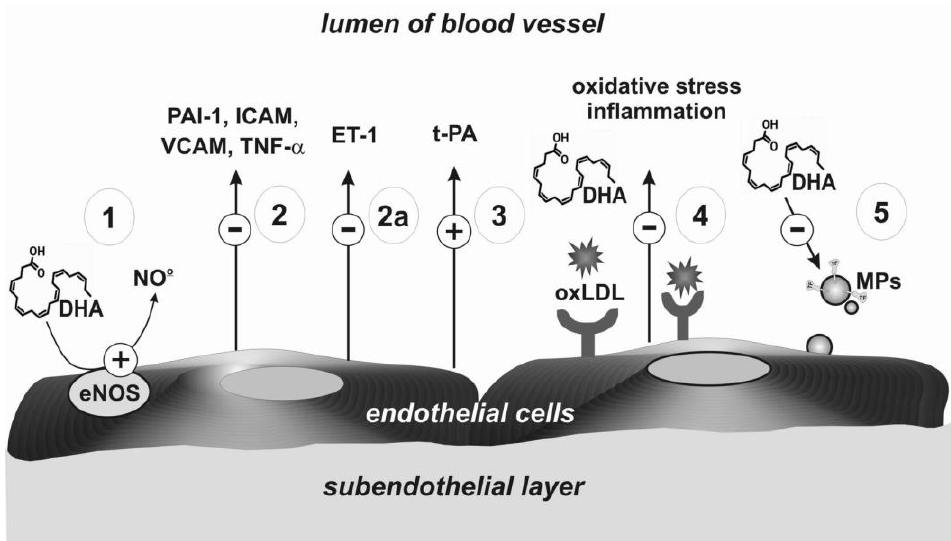
Figure 3. Mechanisms of endothelium regulation mediated by EPA, DHA, and their metabolites. Abbreviations: ET-1: